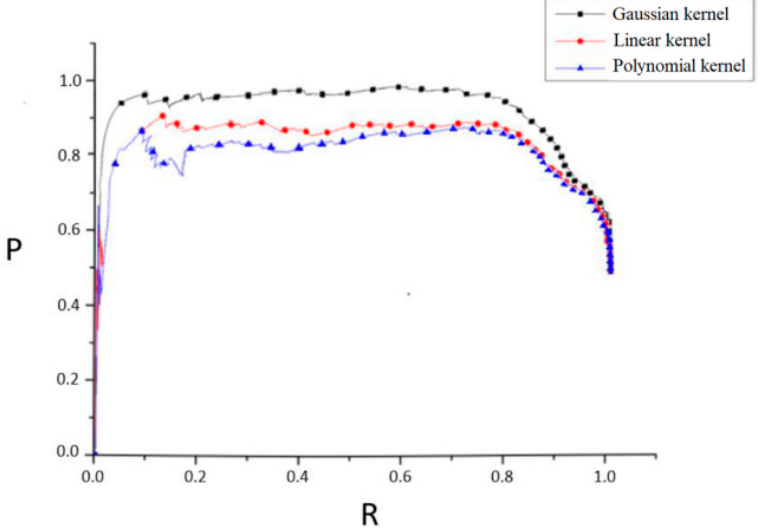
Figure 14. P-R curve of SVM classifier with different kernel function.